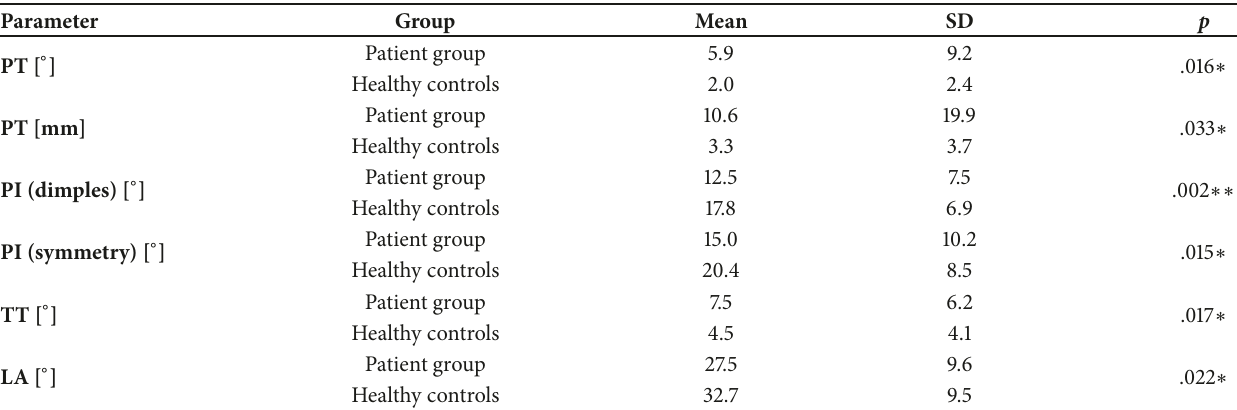
Table 2: Parameters of trunk, lumbar spine, and pelvis.